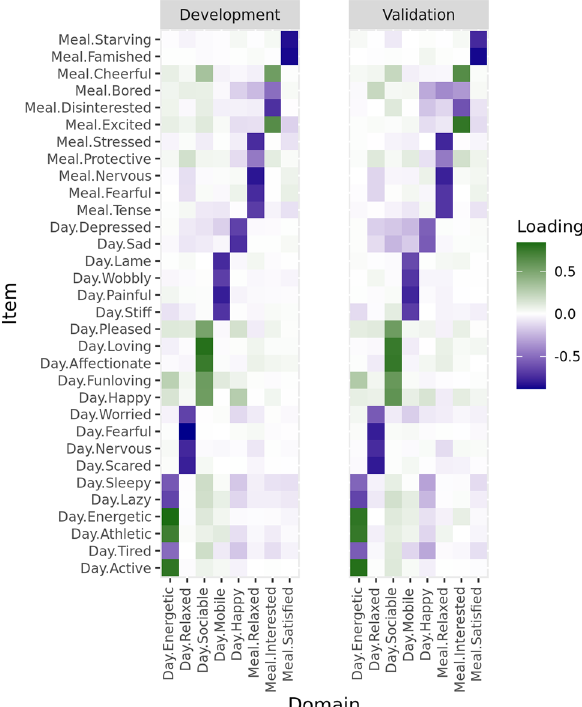
Figure 1. Instrument factor loadings and domain mapping obtained for instrument development (1996 surveys) and for an independent validation (817 surveys). Item and domain prefixes day and meal refer to daytime and mealtime,